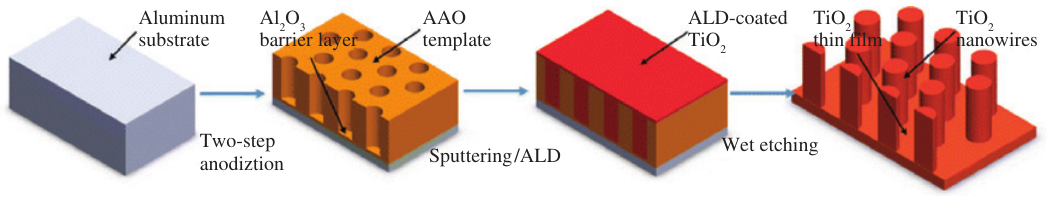
Figure 8: Schematic diagram of the processes to produce nanowire arrays. Reprinted with permission from Ref. [44]. Copyright 2015 Springer.